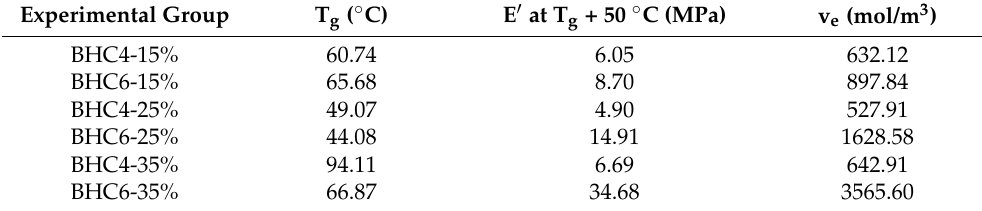
Table 3. Viscoelastic properties of MF coating films for the experimental group. Experimental Group